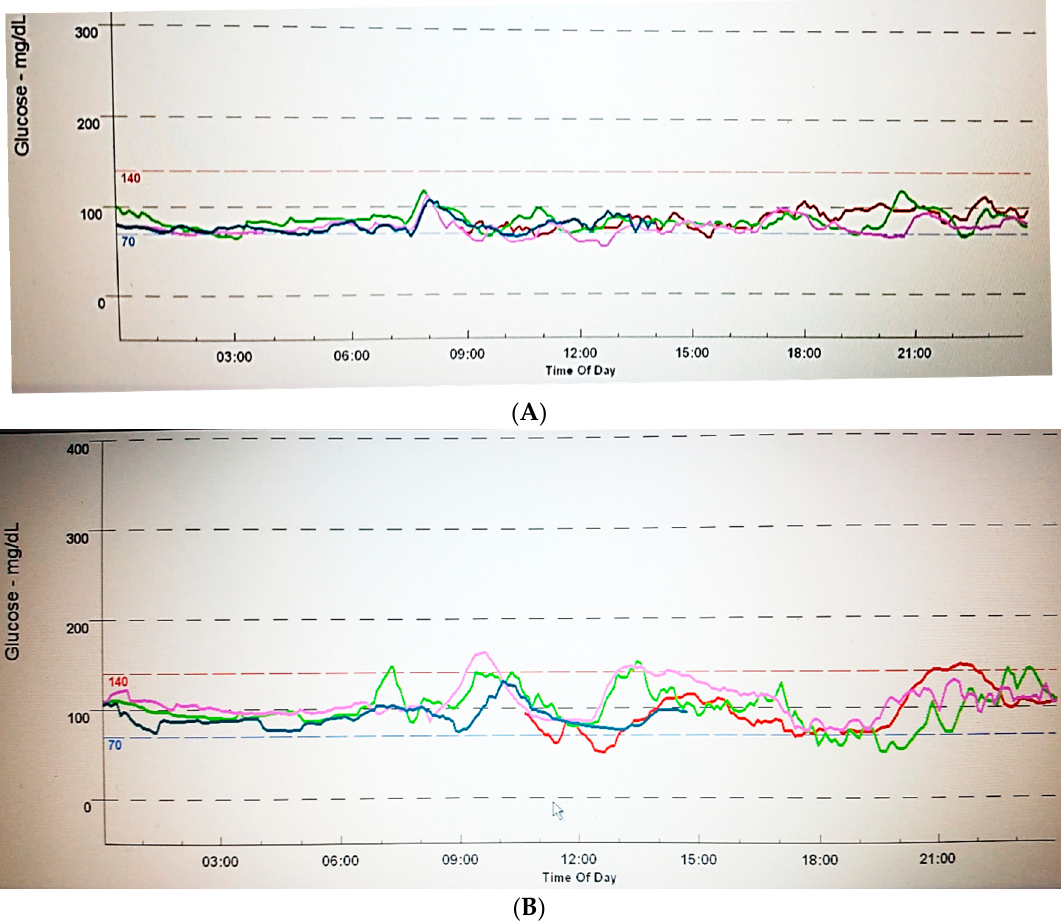
Figure 1. Seventy-two-hour Continuous Glucose Monitoring Data (mg/dL) taken from the CGMS monitor (1 mg/dL = 0.05 mmol/L). Each line represents a 24-h monitoring. ( A ) Non-diabetic pregnant woman; ( B ) Gestational diabetes woman before treatment.